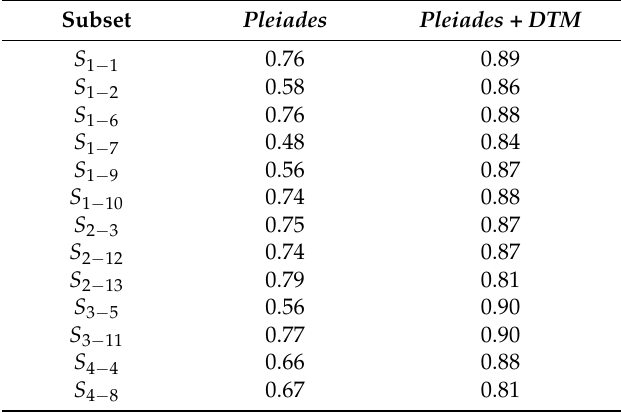
Table 5. The accuracy comparison between Pleiades and Pleiades + DTM by random sets (see notations in Table 3 for the name of